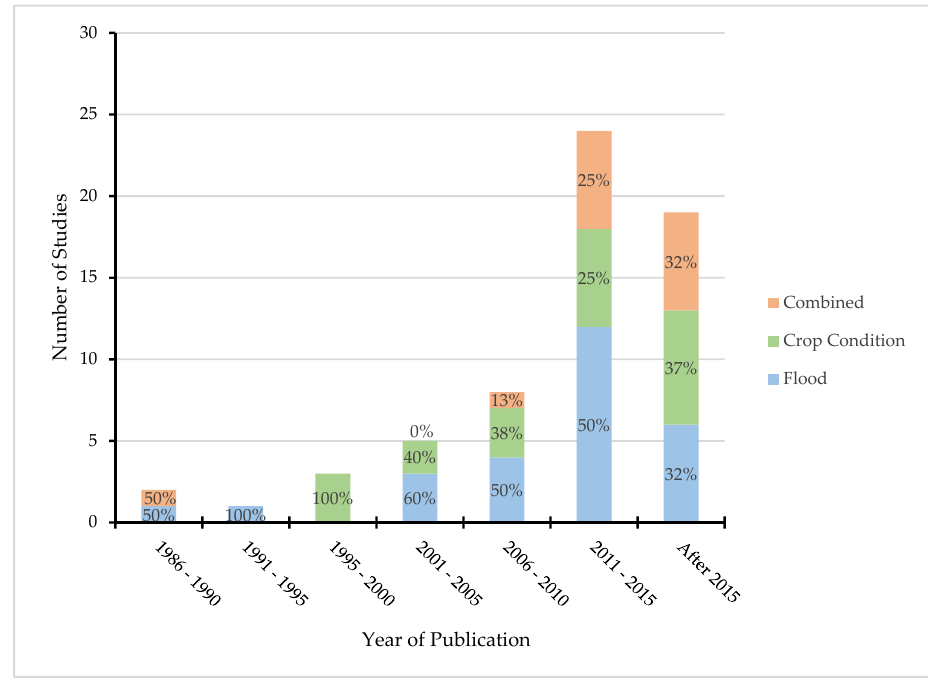
Figure 6. Temporal distribution of case studies categorized by flood crop loss assessment approach.